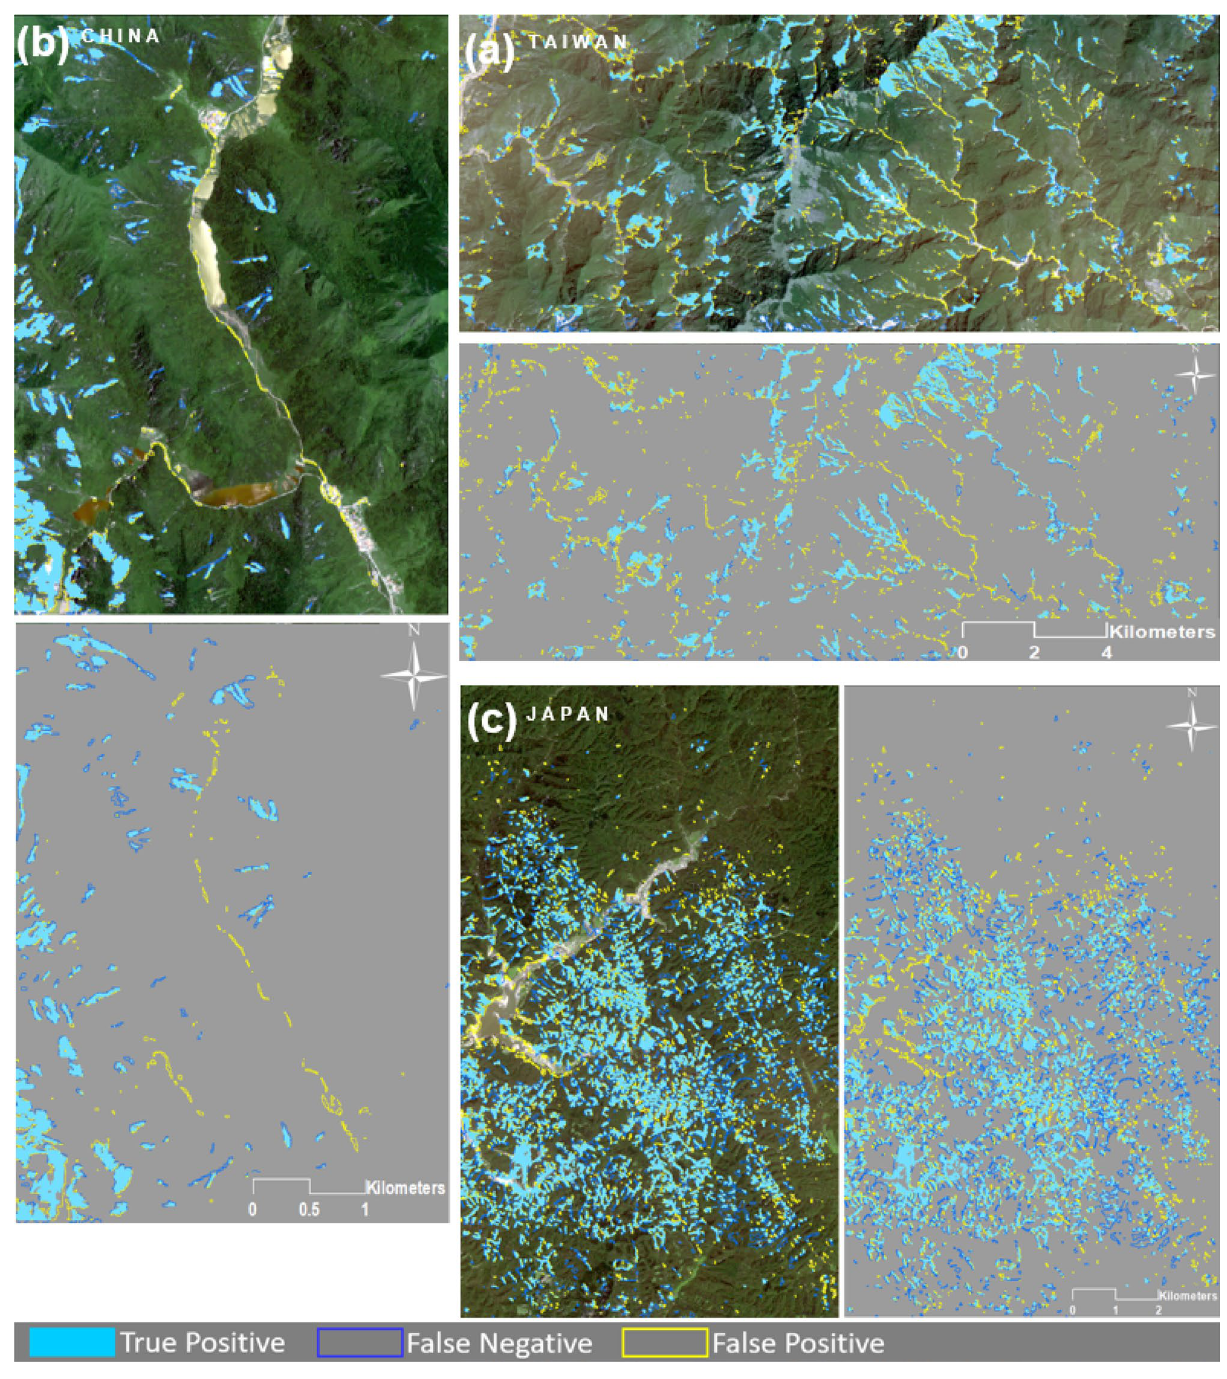
Figure 6. Results of the ResU-Net trained by all training datasets using a sample patch size of 64 × 64 pixels. The maps were created using Python 3.6 (https:// www. python. org/) and the ArcMap v.10.8 software (https:// deskt op. arcgis. com/ es/